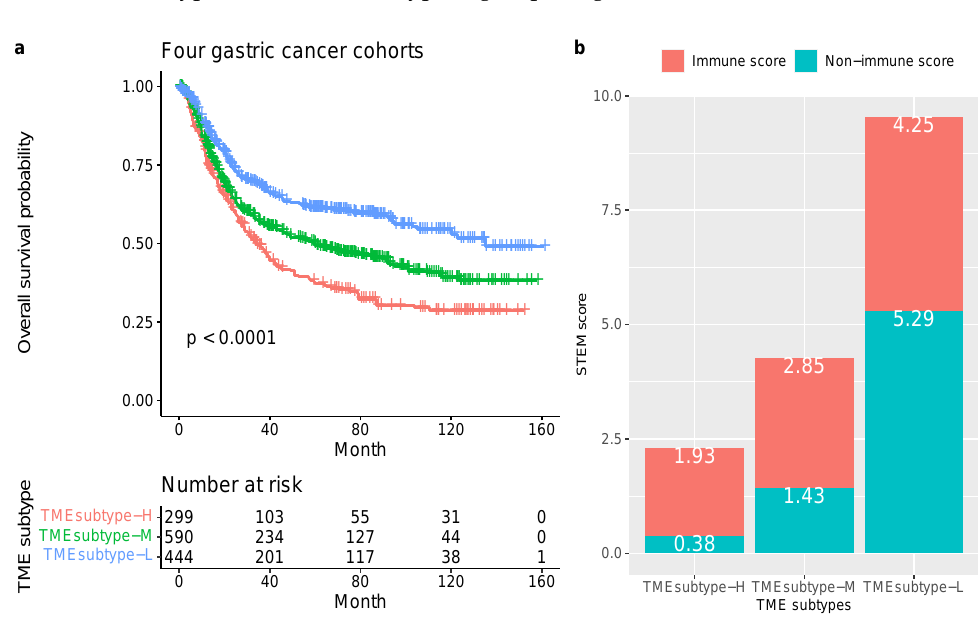
Figure 16. TME subtypes in gastric cancer. ( a ) Kaplan–Meier plots for the OS of patients stratified into three TME subtypes in the meta cohort (ACRG, GSE15459, GSE84437, and TCGA-STAD). Significance test p value is shown in the lower left. ( b ) The mean non-immune and immune scores with TME